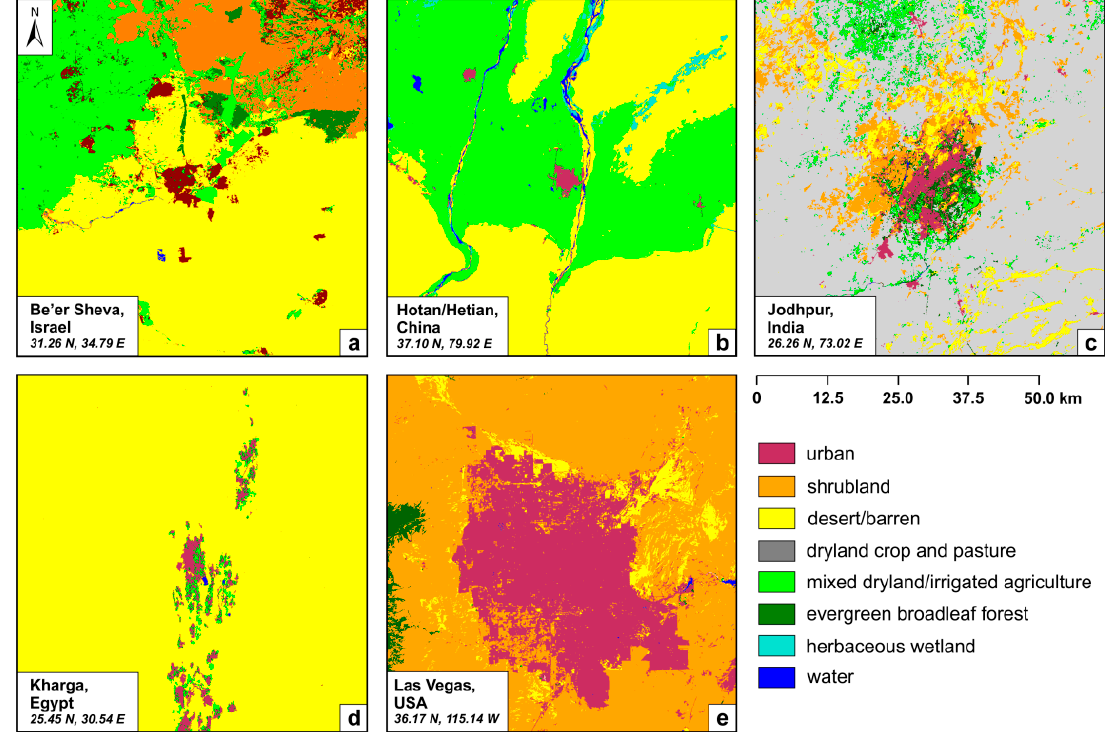
Figure 4. Land cover/land use (LCLU) classification maps for the five desert cities (classified output maps of the images shown in Figure 2): ( a ) Beer Sheva, Israel; ( b ) Hotan, China; ( c ) Jodhpur, India; ( d ) Kharga, Egypt; ( e ) Las Vegas, NV, USA. Table 2. Classification accuracies of LCLU maps.